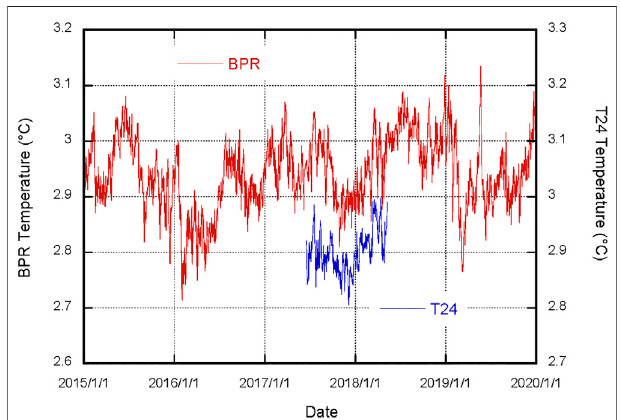
FIGURE8| Dailyrunningaveragesoftheinternaltemperaturesensorfor BPR NC89 deployed near the ONC Clayoquot Slope node, ∼ 3 km southeast of Hole U1364A. Also shown is the 11-months record of the uppermost Hole U1364A thermistor 4 m above sea fl oor, with an offset in the vertical temperature scale to avoid obscuring the BPR record during that